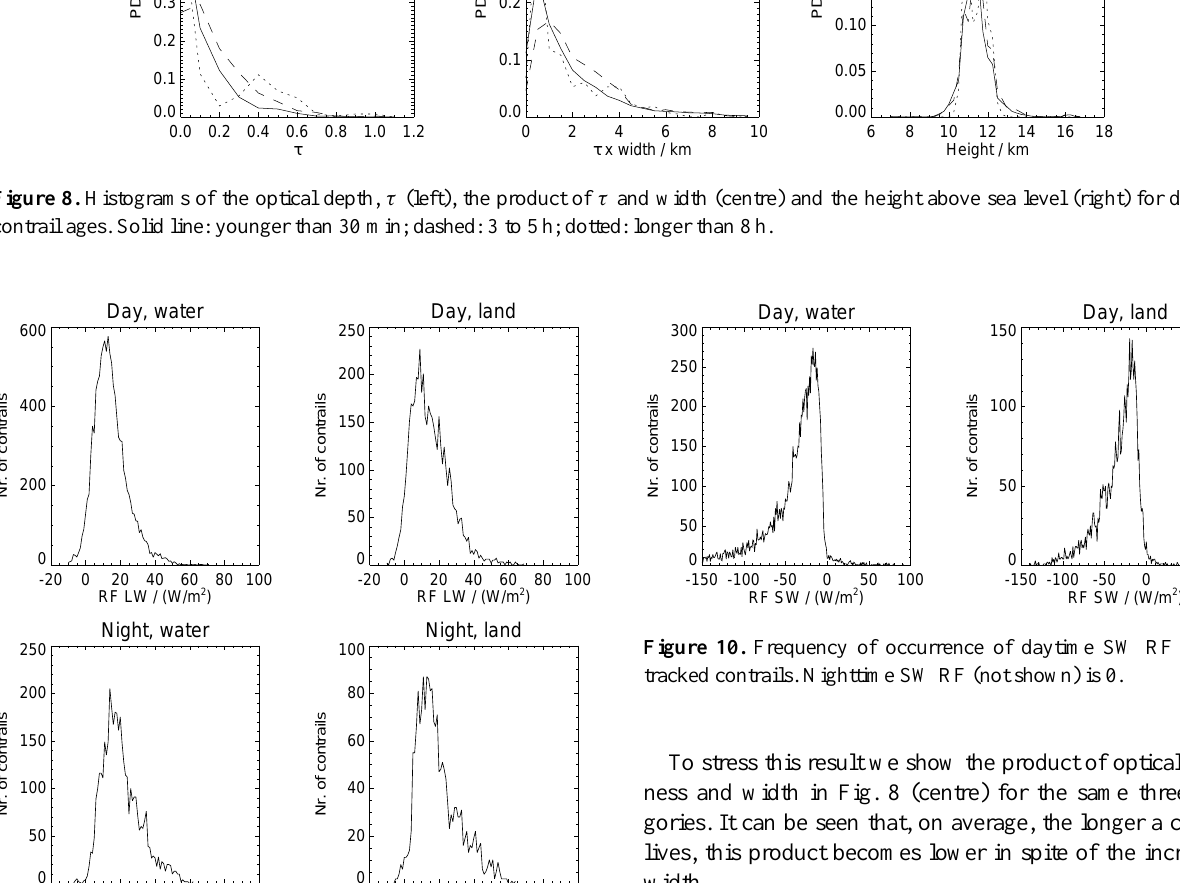
Figure 9. Frequency of occurrence of LW radiative forcing for the tracked contrails.